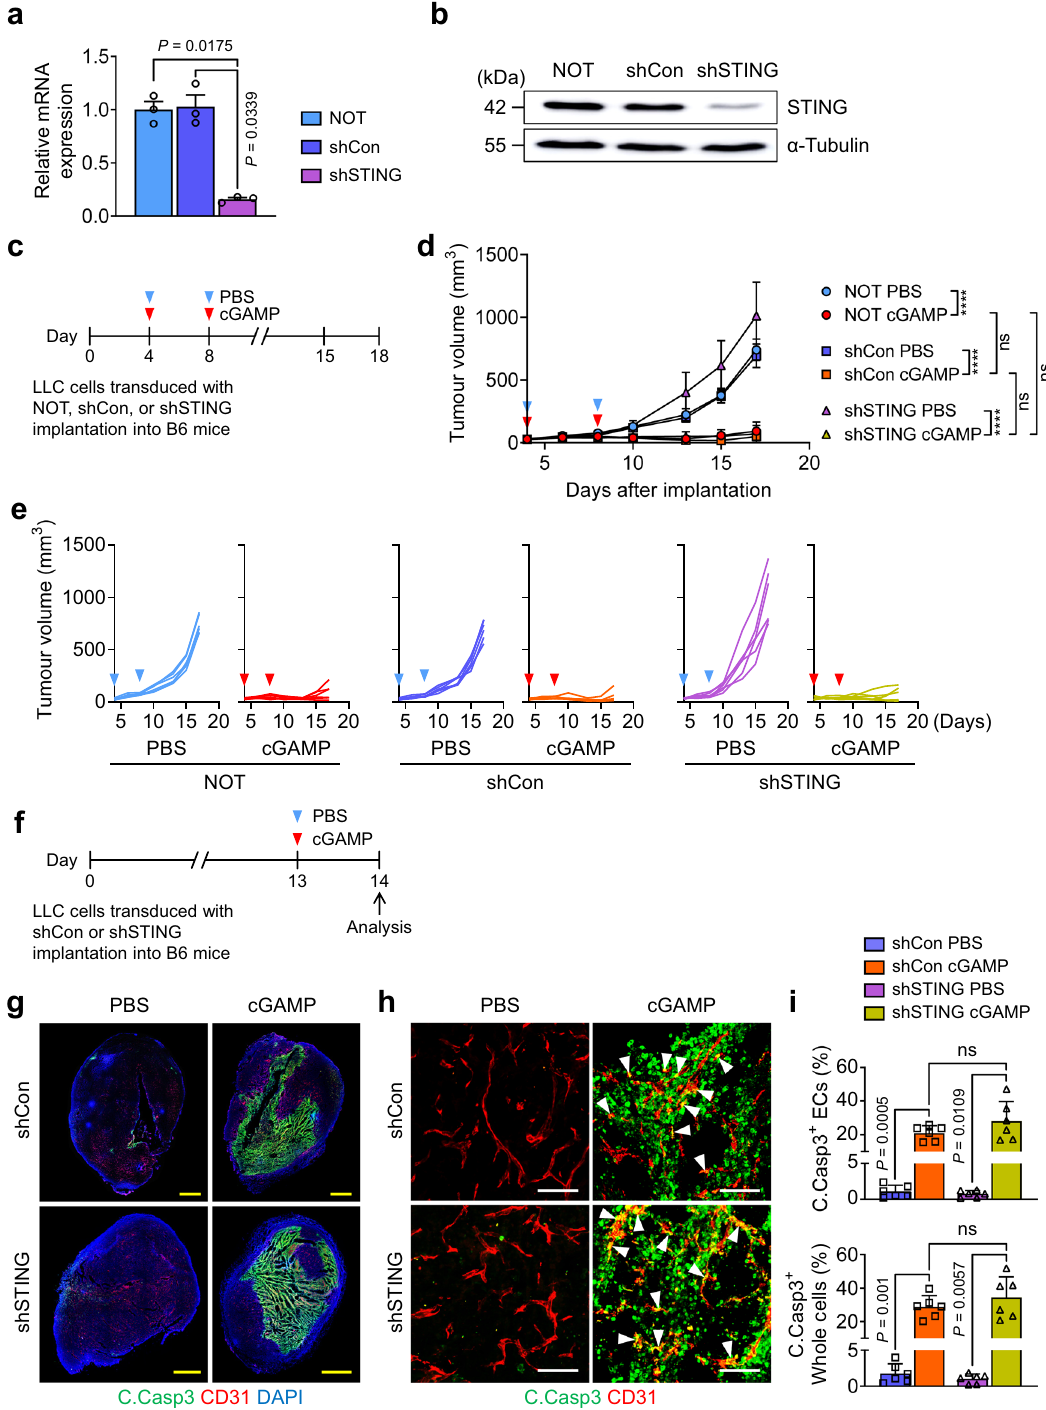
Fig. 3 STING pathway of tumour cells is not required for cGAMP-induced tumour EC apoptosis. a , b mRNA and protein levels of STING in cultured LLC cells transduced with nothing (NOT), shControl (shCon) or shSTING. Each dot indicates a value from one sample and n = 3 from two independent experiments. Vertical bars indicate mean ± SD. c – e Diagram depicting generation of implanted LLC tumour by injection of the LLC cells transduced with NOT, shCon or shSTING, and treatment schedule of i.t. PBS or cGAMP in B6 mice. Comparison of LLC tumour growths. n = 6 mice/group from three independent experiments. Dots and bars indicate mean ± SD. Plot indicates each individual tumour growth. f – i Diagram depicting generation of implanted LLC tumour by injection of the LLC cells transduced with shCon or shSTING, i.t. PBS or cGAMP treatment, and sampling of tumours at 24 h later. Representative images and comparisons of apoptosis in tumour ECs and whole tumour cells (whole cells). White arrowheads indicate apoptotic ECs. Scale bars, 1.0 mm (yellow) and 100 μ m (white). Each dot indicates a value from one mouse and n = 6 mice from four independent experiments. Vertical bars indicate mean ± SD. P values by Welch ’ s one-way ANOVA test followed by Dunnett ’ s T3 test ( a , d , i ). **** P < 0.0001; ns, not signi fi cant. Source data are provided as a Source Data fi